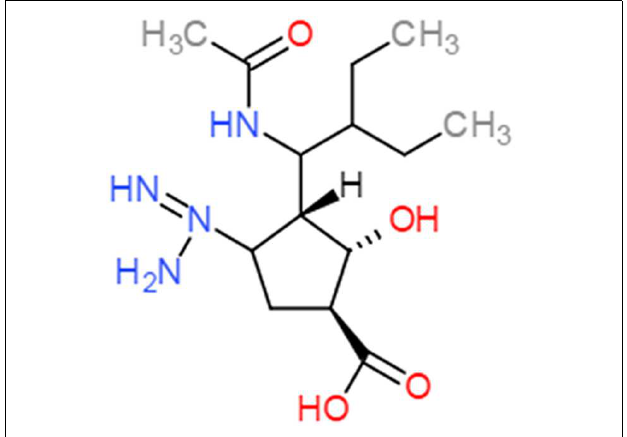
FIGURE 1 | Chemical structure of